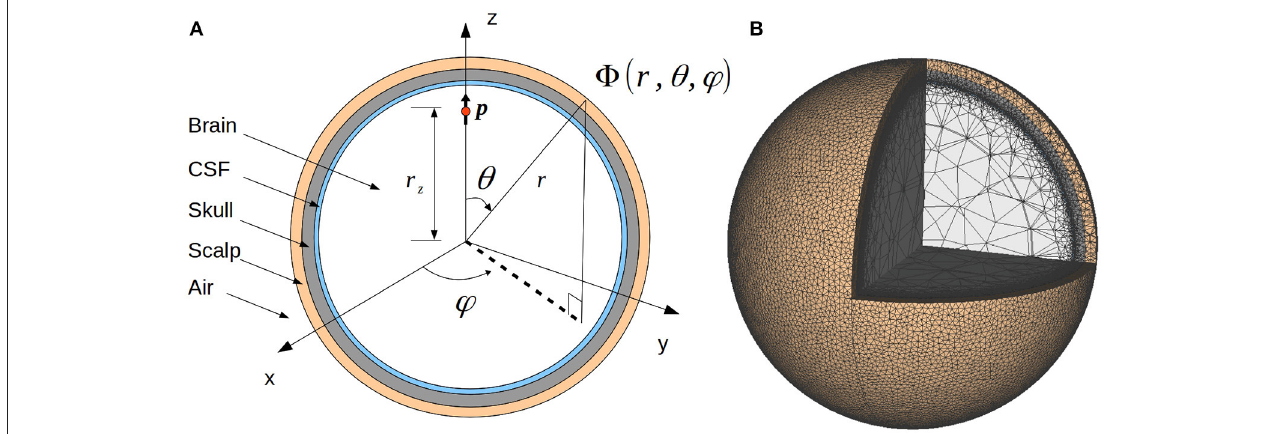
FIGURE 1 | Illustration of the four-sphere head model. (A) Cross-section of the four-sphere head model, with the different colors corresponding to the different head layers: brain, CSF, skull, and scalp. The current dipole p is located in the brain layer, at a distance r z from the center of the sphere. In all the subsequent figures, the dipole is placed in the x = 0 plane, at the z-axis ( r z = 7.8 cm). (B) Mesh of the four-sphere model used in the FEM simulations illustrating the different electrical conductivity values for each of the spheres.